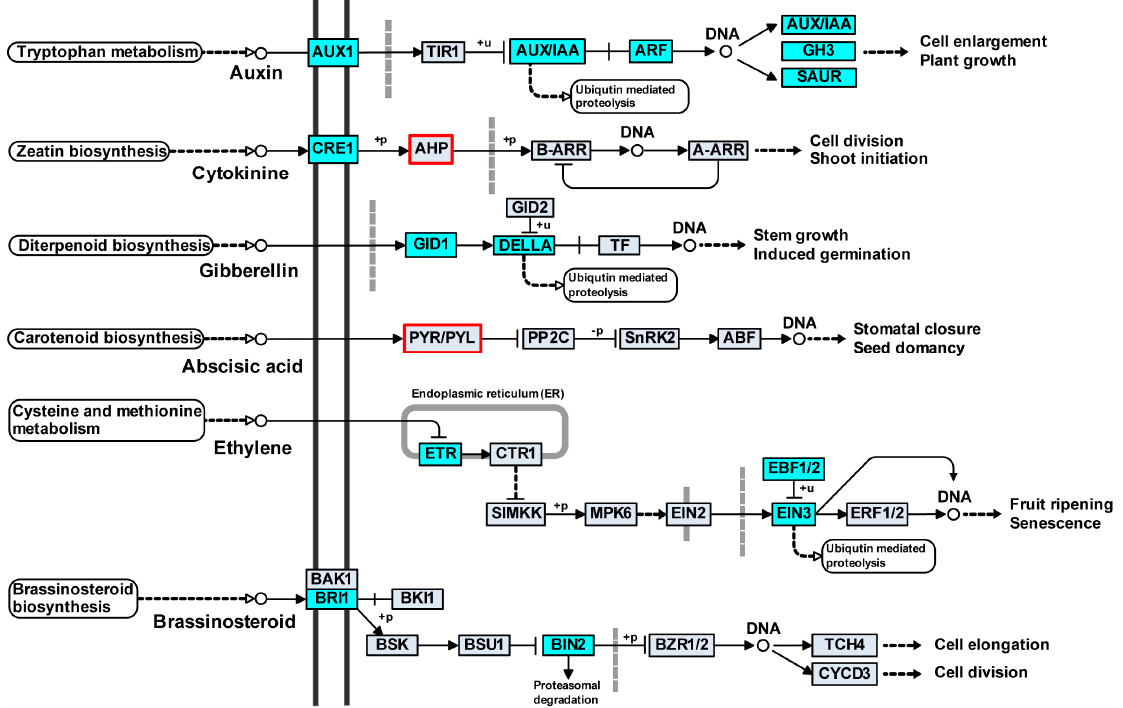
Figure 4. Differentially expressed genes involved in hormone signal transduction pathways in willow. Genes differentially expressed in S. matsudana are shown by cyan and red rectangular frames and those in S. matsudana var. pseudo-matsudana are shown by cyan boxes. AUX1, auxin influx carrier; AUX/IAA, auxin-responsive protein IAA; ARF, auxin response factor; GH3, auxin responsive GH3 gene family; SAUR, SAUR family protein; CRE1, Arabidopsis histidine kinase 2/3/4 (cytokinin receptor); AHP, histidine-containing phosphotransfer protein; GID1, gibberellin receptor GID1; PYR/PYL, abscisic acid receptor PYR/PYL family; ETR, ethylene receptor; EBF1/2, EIN3-binding F-box protein; EIN3, ethylene-insensitive protein 3; BRI1, protein brassinosteroid insensitive 1; BIN2, protein brassinosteroid insensitive 2.